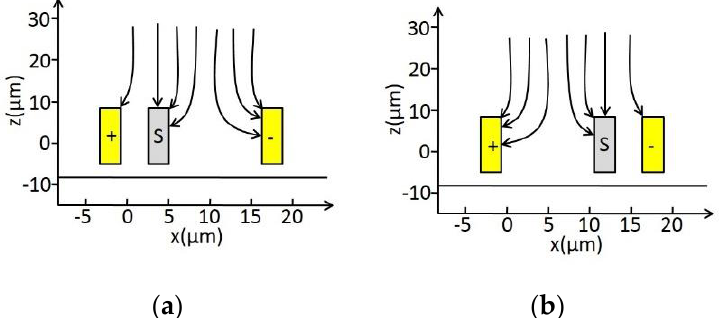
Figure 1. Operating principle of the resonant electric field microsensor (EFM) with coplanar electrodes.